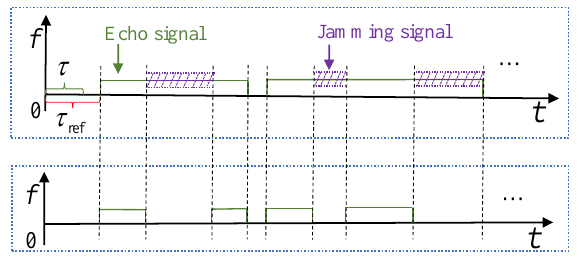
Figure 7. The principle diagram of the jamming